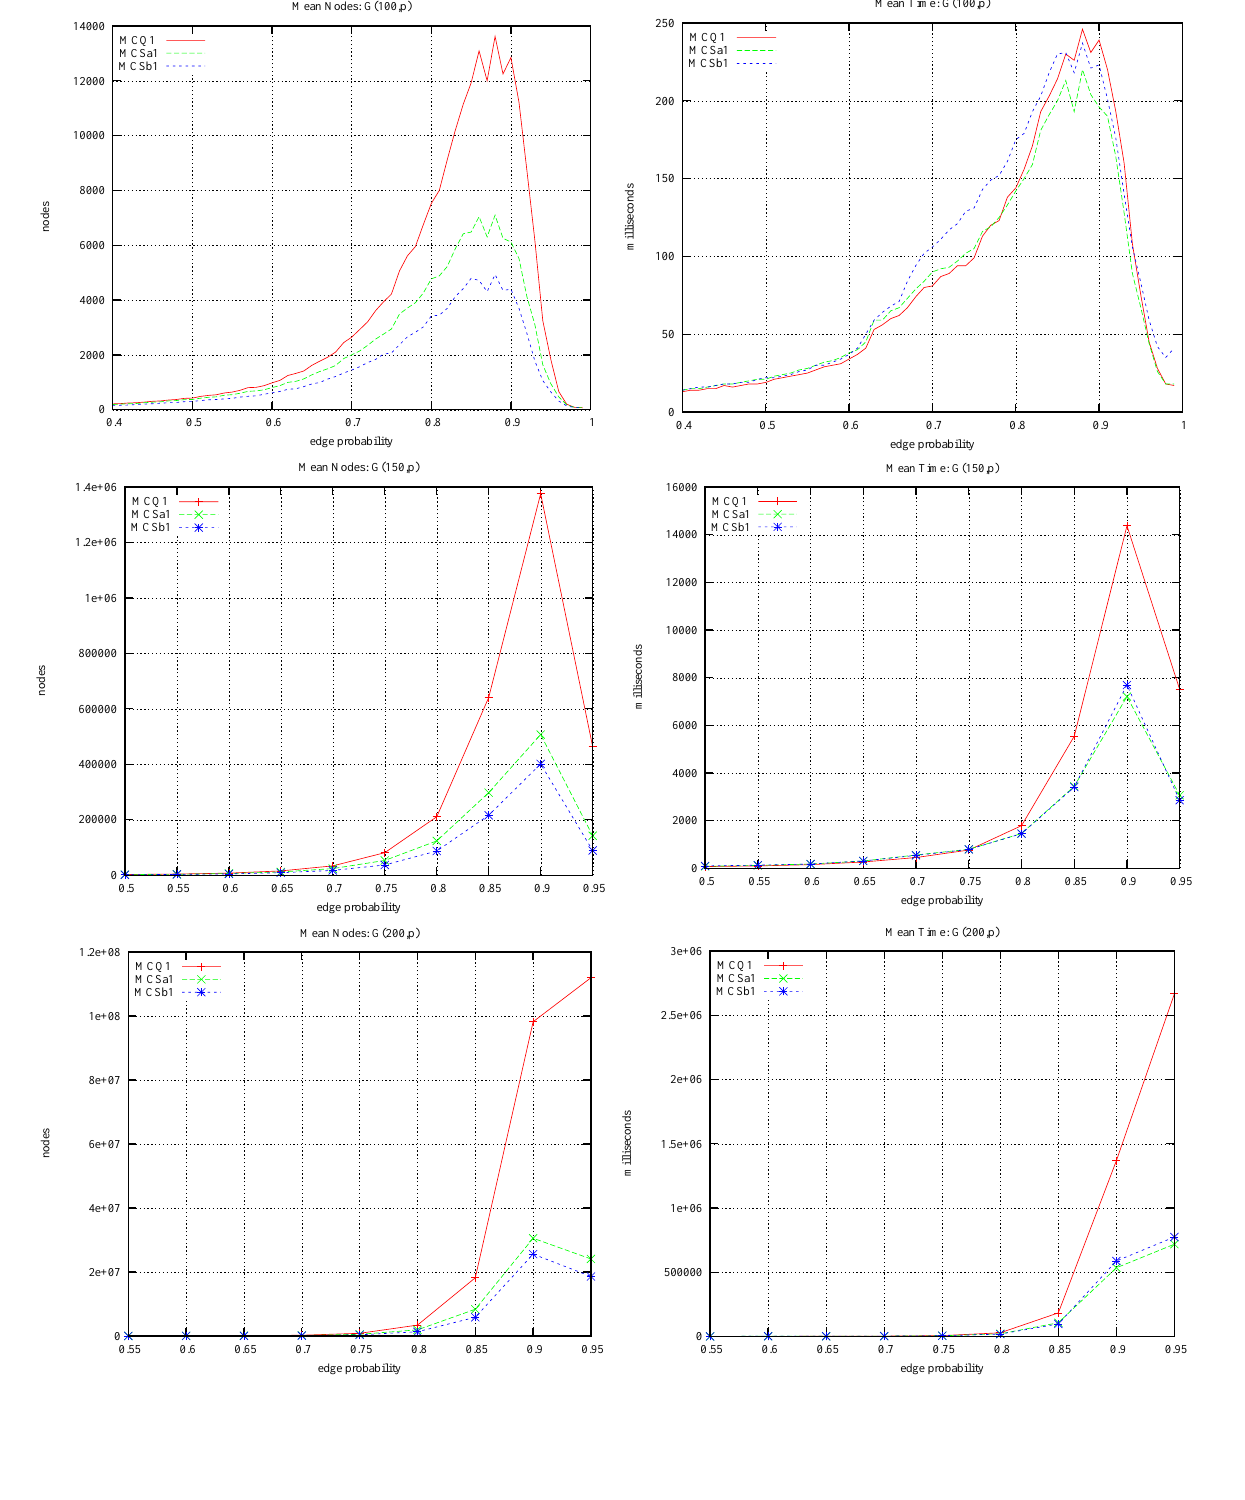
Figure 6. G ( n, p ) , sample size 100. MCQ vs. MCS, where is the win? (left) Search effort in nodes visited ( i.e. , decisions made by the search process); (right) run time in